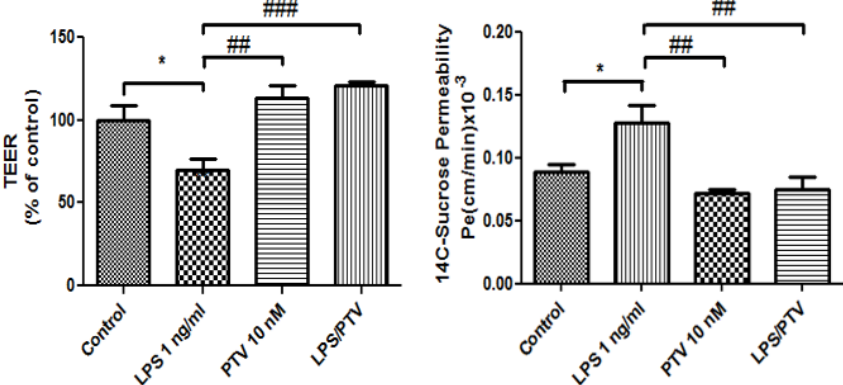
Figure 2. PTV restores LPS-induced changes in TEER and endothelial permeability in an in vitro BBB model. Cells were incubated with PTV in the presence or absence of LPS (added only to the luminal chamber) for 24 h. * p < 0.05 vs. control; ## p < 0.01, ### p < 0.001 vs. LPS (one-way ANOVA, p -values were calculated from Tukey’s Multiple Comparison Test). The TEER and endothelial permeability test were conducted with two technical replicates in triplicate experiments, n = 6 per group.